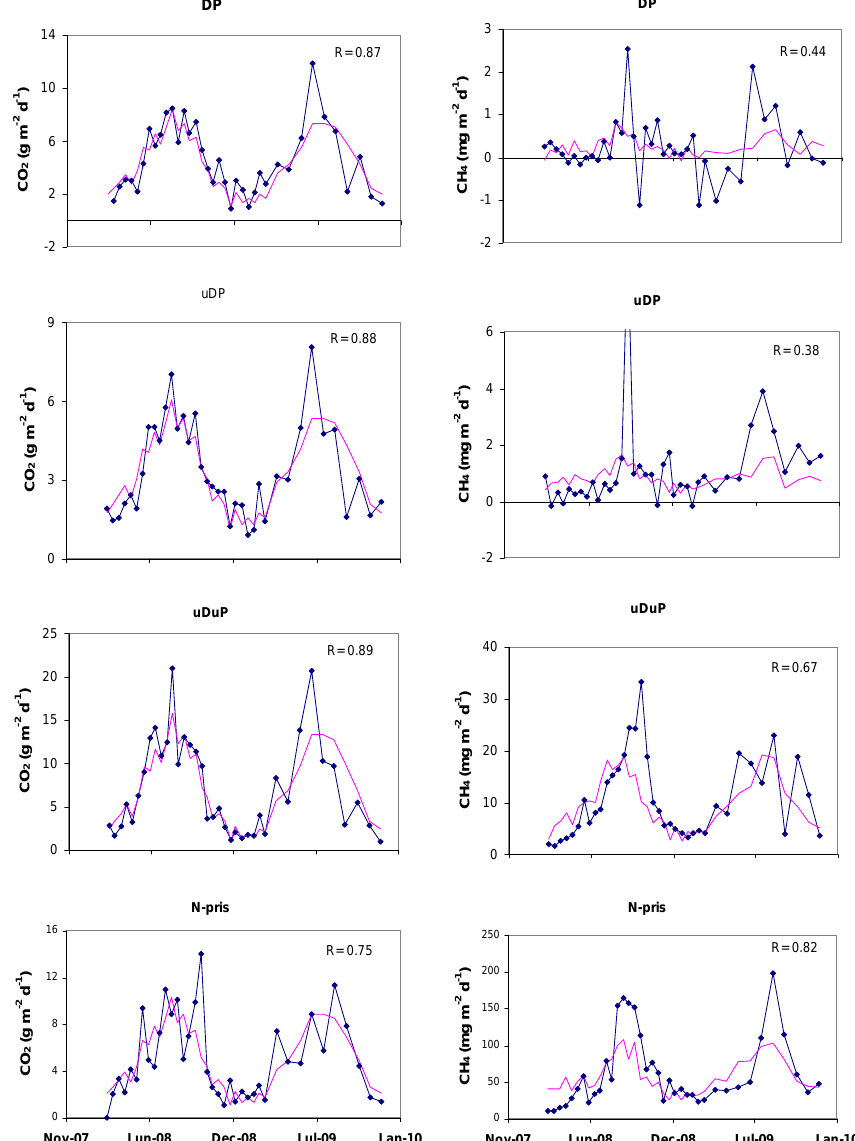
Fig. 7. Modelled (lines) and measured (closed symbol) fluxes of CO 2 and CH 4 for each treatment over the study period. R is the correlation between measured and modelled values.